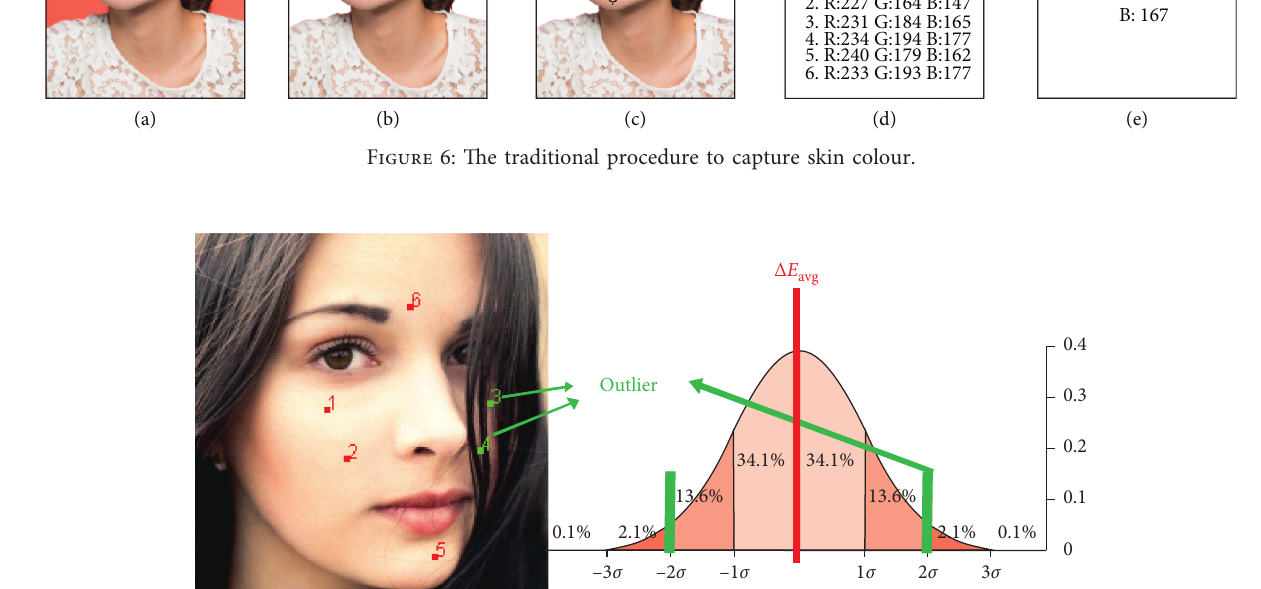
Figure 7: The Gaussian distribution concept and standard